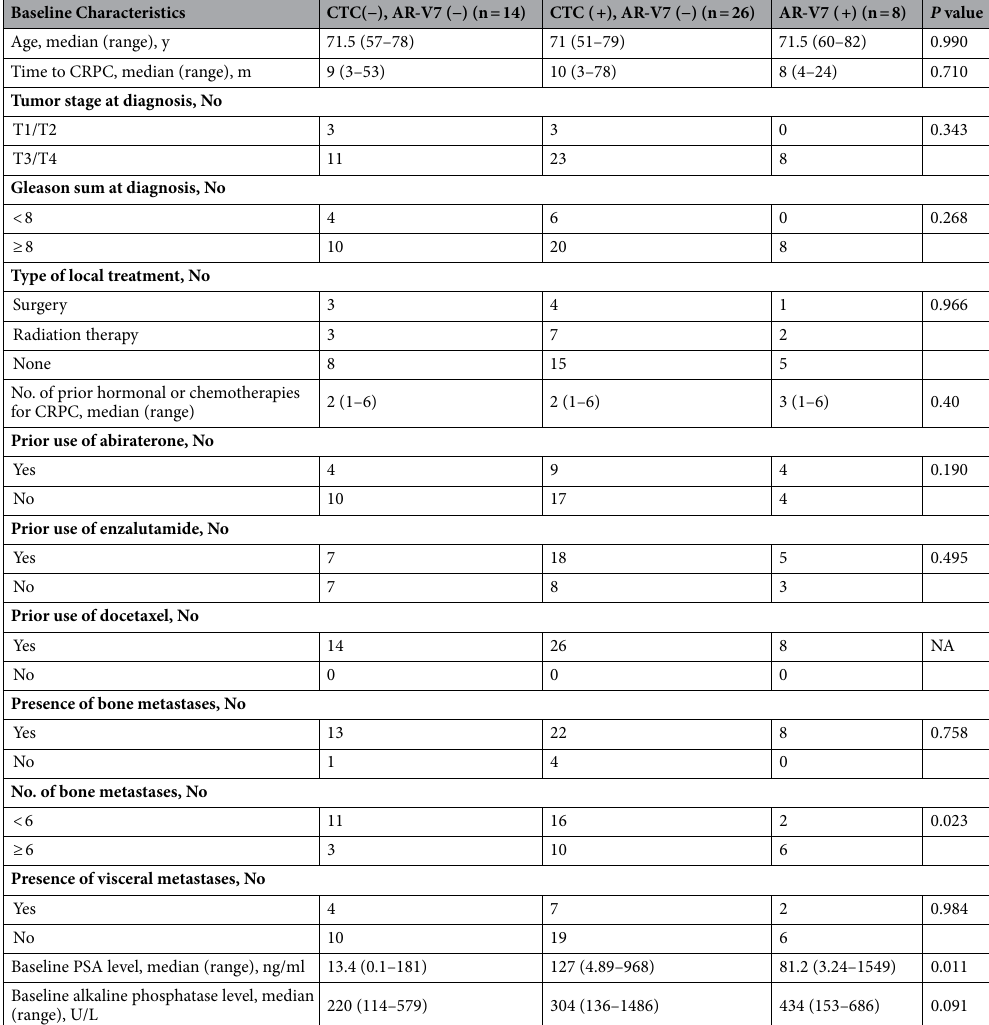
Table 3. Clinical characteristics of patients in the CTC-negative and CTC-positive groups. The CTC-negative and AR-V7-negative groups included 14 patients each. The CTC-positive group included AR-V7-negative (n = 26), and AR-V7-positive (n = 8) patients. The Kruskal–Wallis test was used for statistical analysis of patient characteristics. CRPC castration-resistant prostate cancer, m months, no number, PSA prostate specific antigen, y years, ( − ) negative, (+)